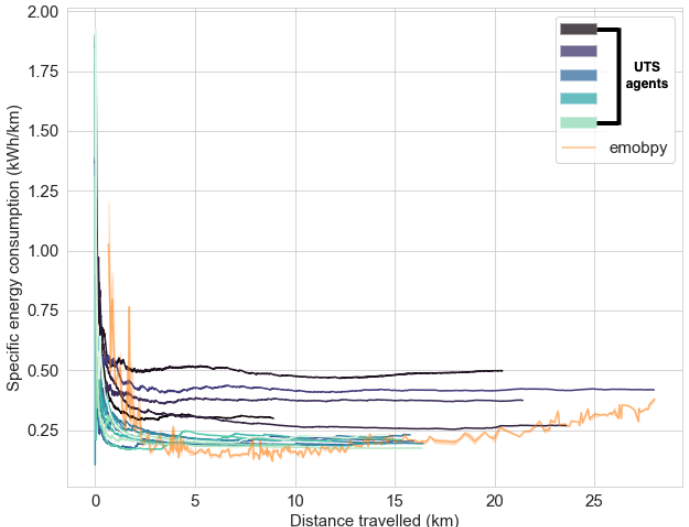
Figure 3. Model output comparison: electric energy consumption (kWh) against distance travelled (km), with 15 vehicles over a 1 h drive cycle (5 vehicles break speed